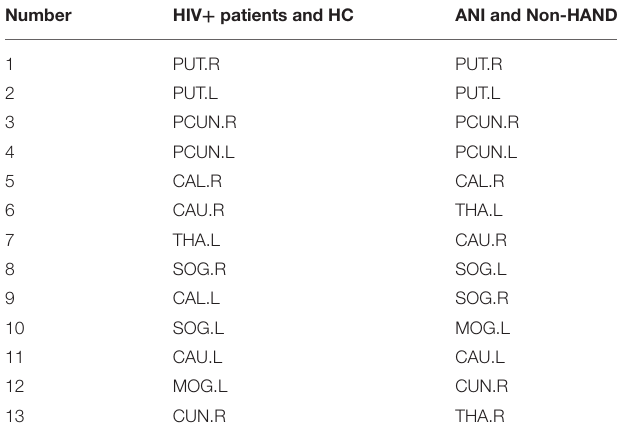
TABLE 3 | Hub regions among pairs of comparing groups (sorted by degree). Number HIV + patients and HC ANI and